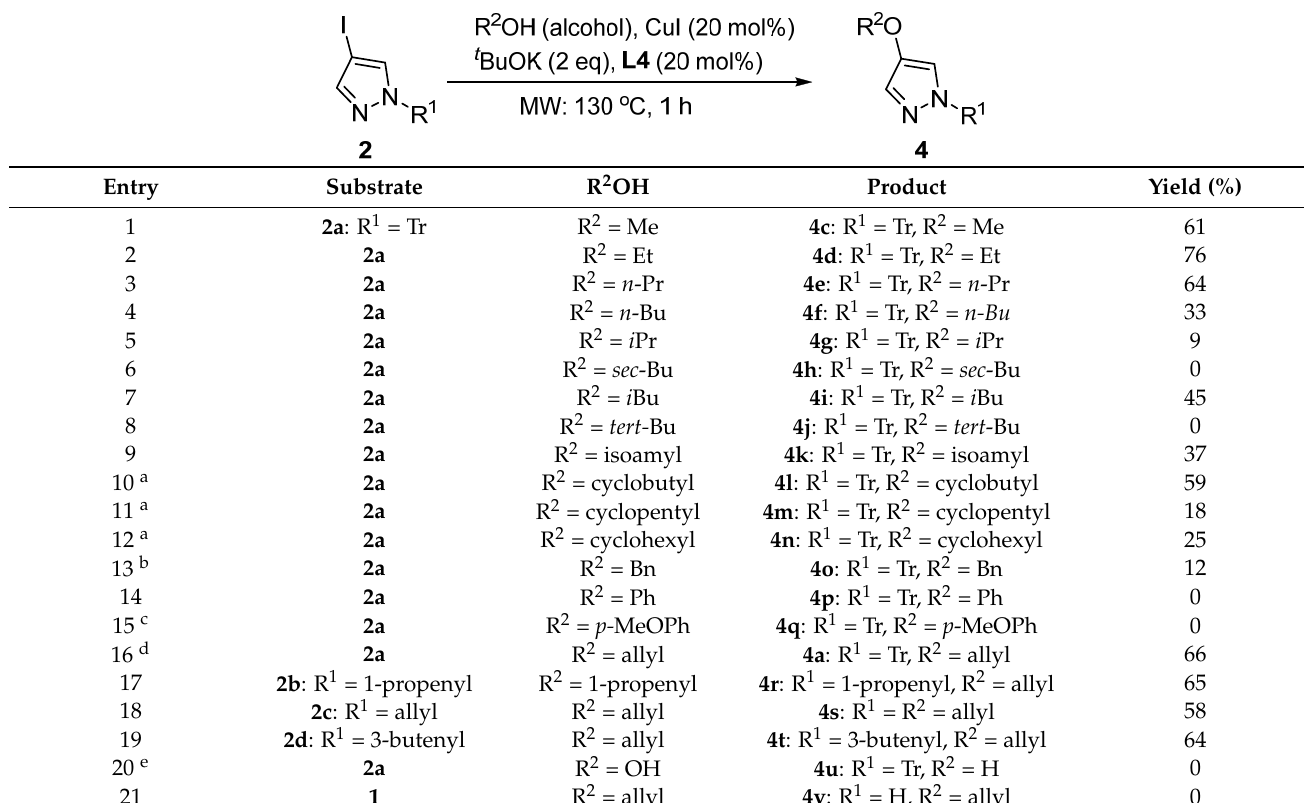
Table 2. CuI-catalyzed coupling reaction between iodopyrazoles and various alcohols.